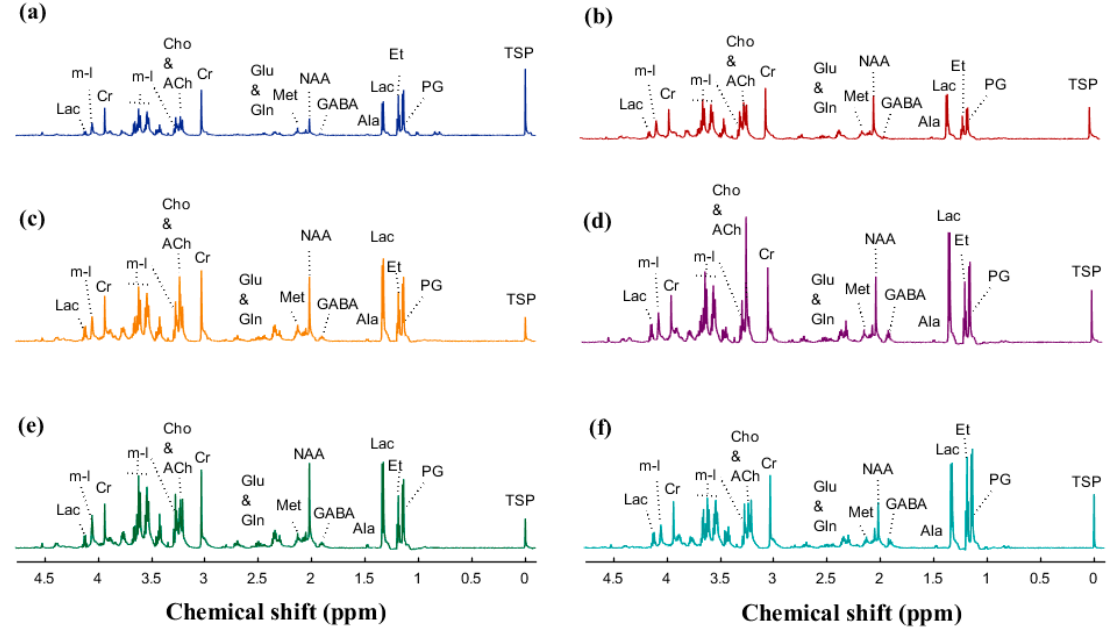
Figure 2. High-resolution magic-angle spinning (HR-MAS) 1 H NMR spectra (obtained at 600 MHz) of control brain samples and the identified metabolites: ( a ) cerebellum, ( b ) periventricular white matter, ( c ) striatum, ( d ) hypothalamus, ( e ) prefrontal cortex, and ( f ) midbrain. Abbreviations: Ala: alanine;